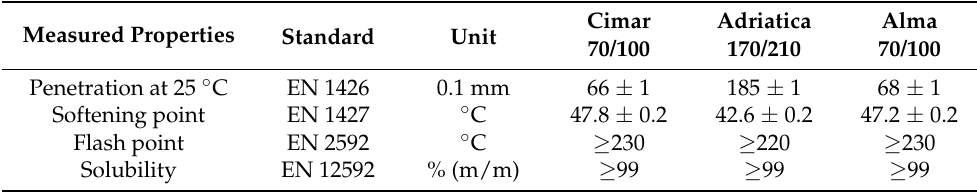
Table 1. Physical properties of bitumens used in this study. Measured